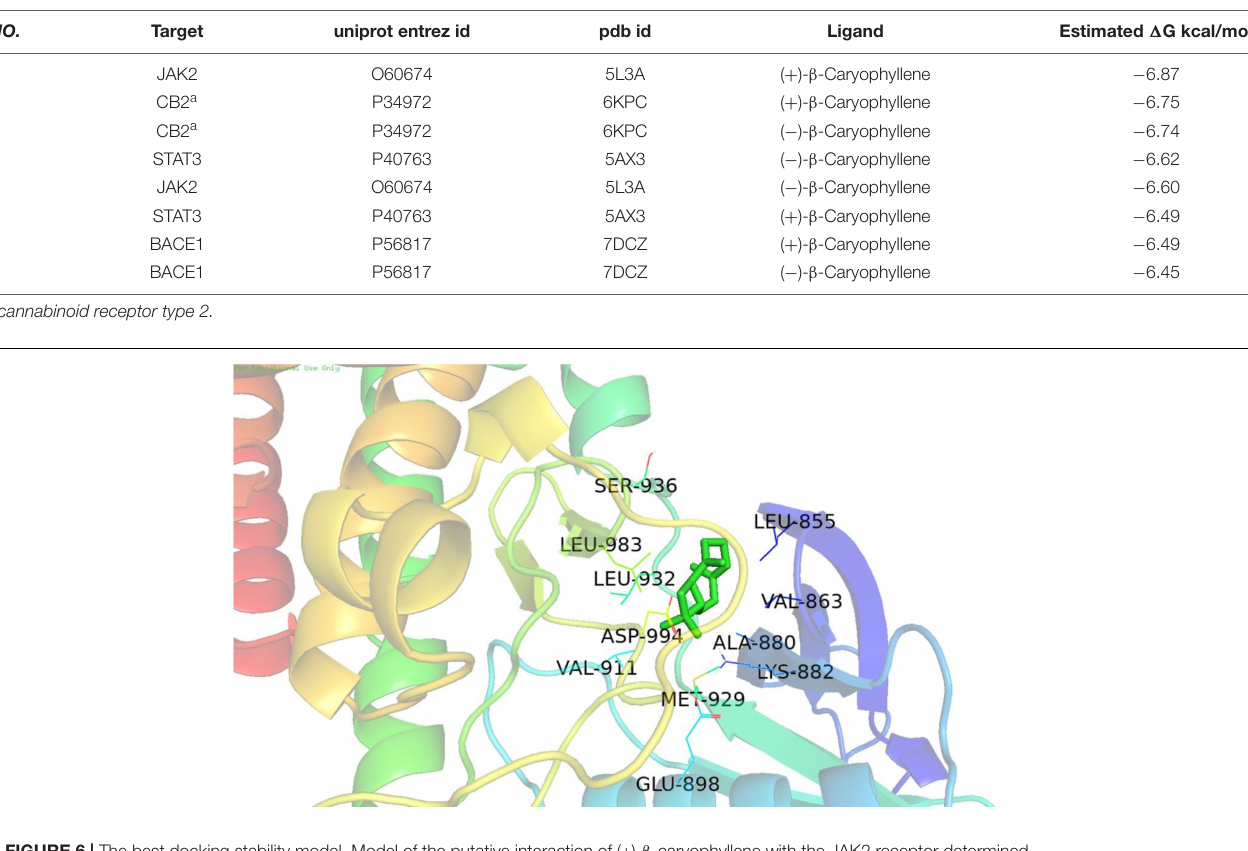
TABLE 4 | Results of molecular docking.